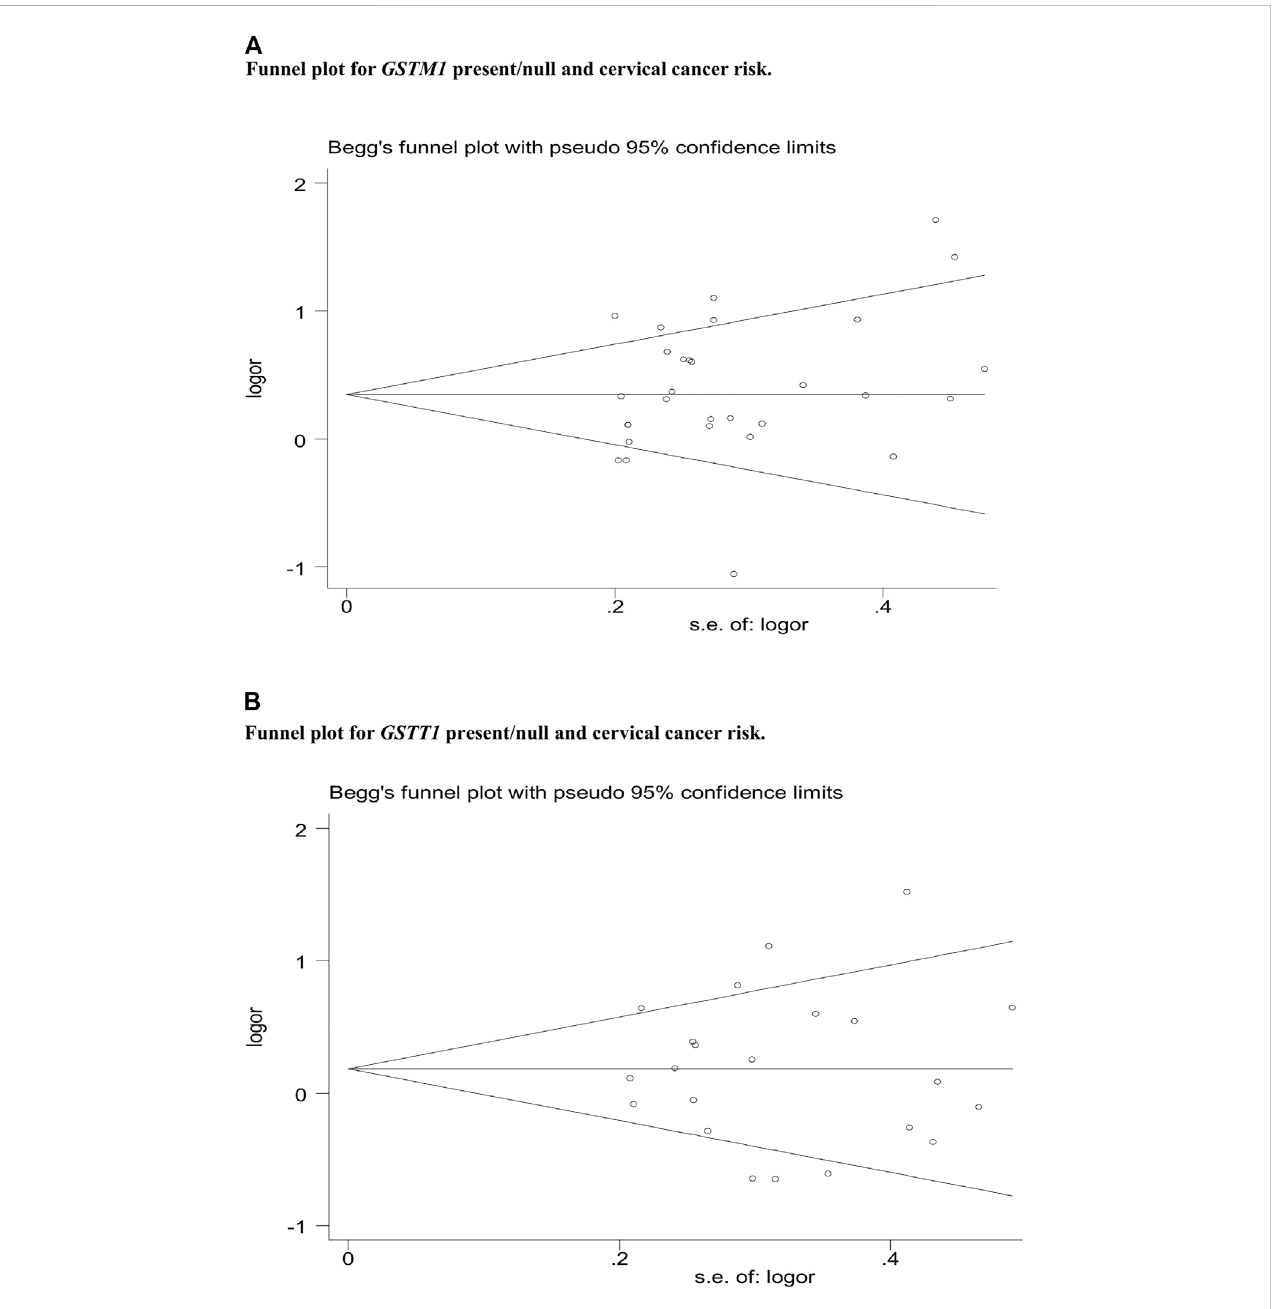
FIGURE 6 (A) Funnel plot for GSTM1 present/null and cervical cancer risk. (B) Funnel plot for GSTT1 present/null and cervical cancer